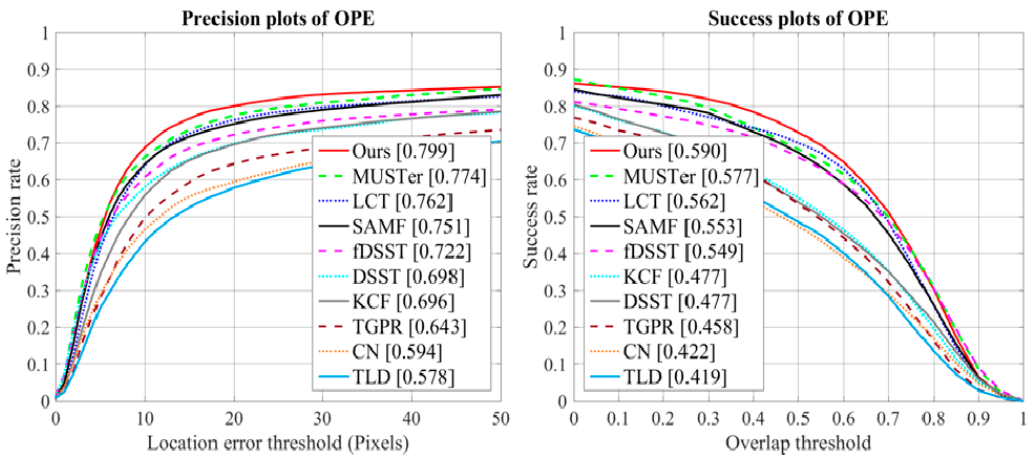
Figure 3. Precision and success plots on OTB-2015 using OPE.